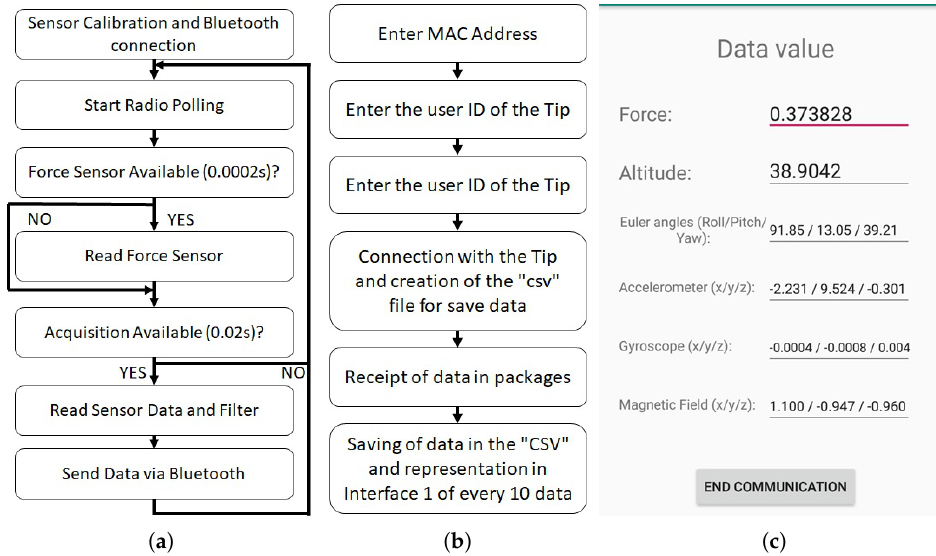
Figure 2. ( a ) Operation scheme of the Bluetooth Low Energy (BLE) Nano V2 software, responsible for capturing the data coming from the sensors and sending them via Bluetooth. ( b ) Scheme of operation of the PC/Mobile Phone interface. ( c ) Representation of one of the screens of the smartphone application developed for the storage of the data received from the Sensorized